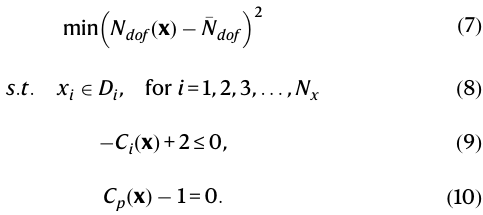
Fig. 3a.3, a.8. To attain the target mobility algorithm of recon fi gurable structures.